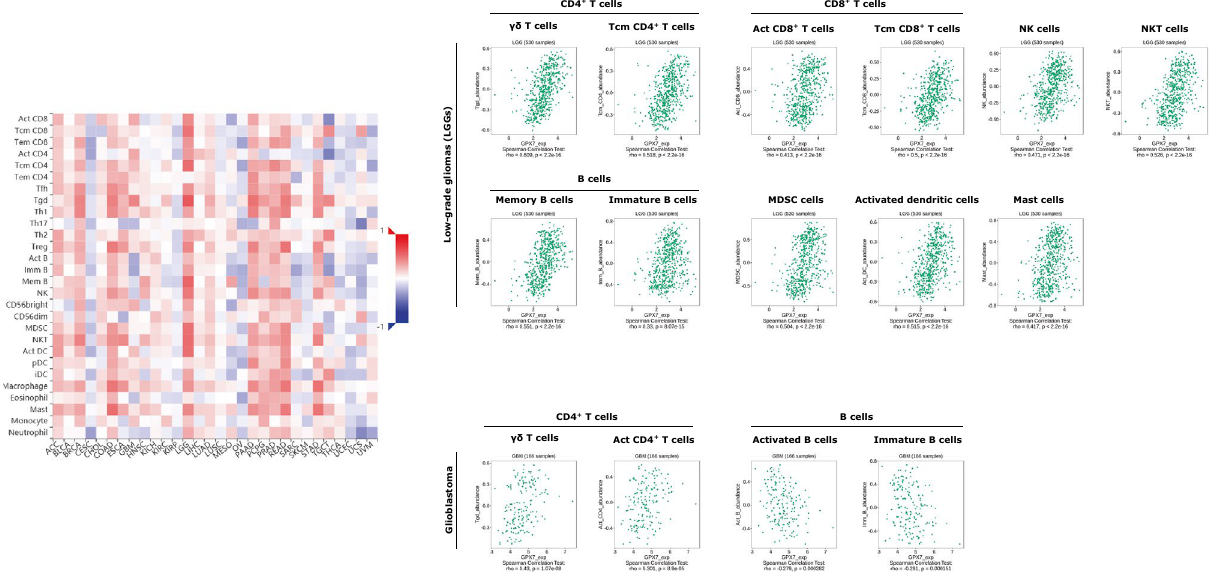
Figure 12. Correlation between GPX7 expression and tumor-infiltrating immune cells. Left panel: Correlative heat-map between GPX7 and 28 tumor-associated immune cells (Vertical axis) in a pan-cancer cohort (Horizontal axis). The colors indicate the correlation coefficients; Upper panel: correlation between GPX7 expression and immune-related signatures from (i) gamma delta T cells ( γδ T cells); (ii) central memory CD4 + T cells (Tcm CD4 + T cells); (iii) activated CD8 + T cells (Act CD8 + T cells); (iv) central memory CD8 + T cells (Tcm CD8 + T cells); (v) NK cells; (vi) NKT cells; (vii) memory B cells; (viii) immature B cells; (ix) Myeloid-derived suppressor cells (MDSC cells); (x) activated dendritic cells; (xi) mast cells in low-grade gliomas (LGG). Lower panel: correlation between GPX7 expression and immune-related signatures from (i) gamma delta T cells ( γδ T cells); (ii) activated CD4 + T cells (Act CD4 + T cells); (iii) activated B cells; (iv) immature B cells in glioblastoma